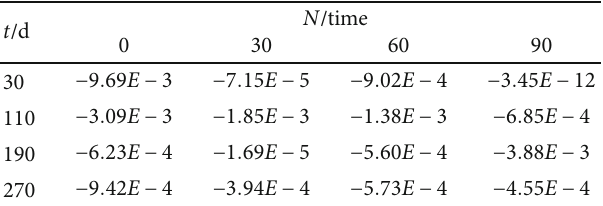
Table 2: Values of the parameter A and corrosion time.